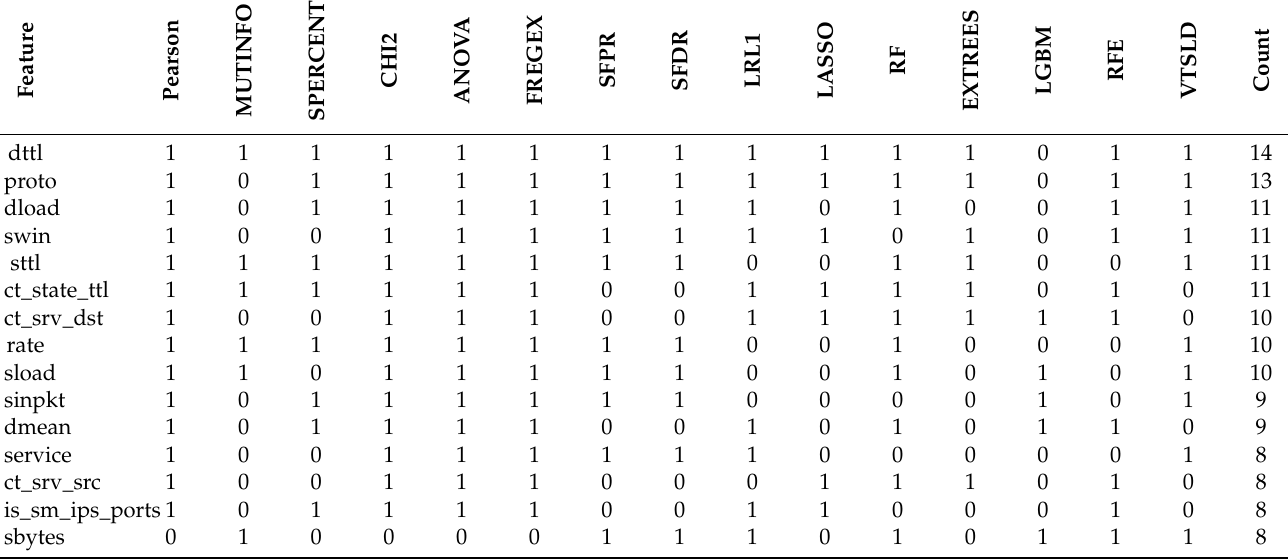
Table 6. Ensemble feature set selected by most the FS